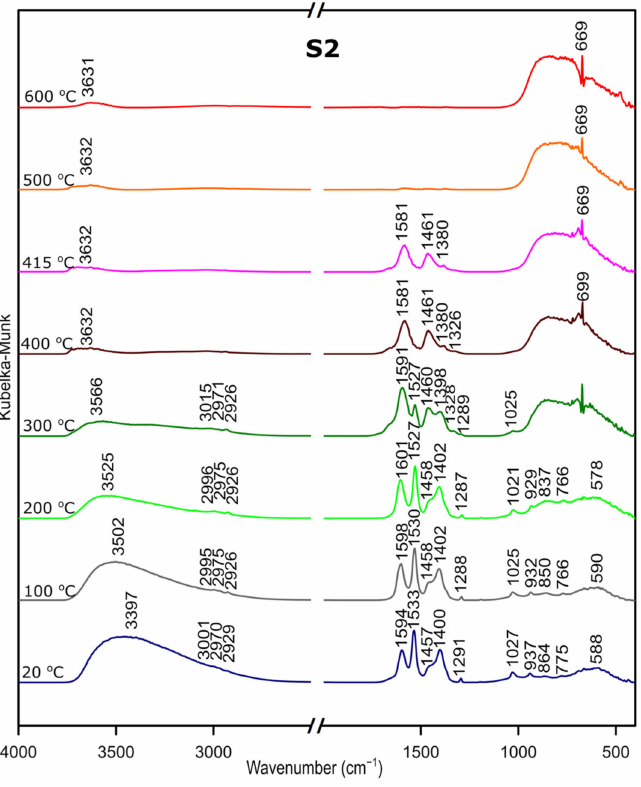
Figure 6. DRIFTS results for the sample